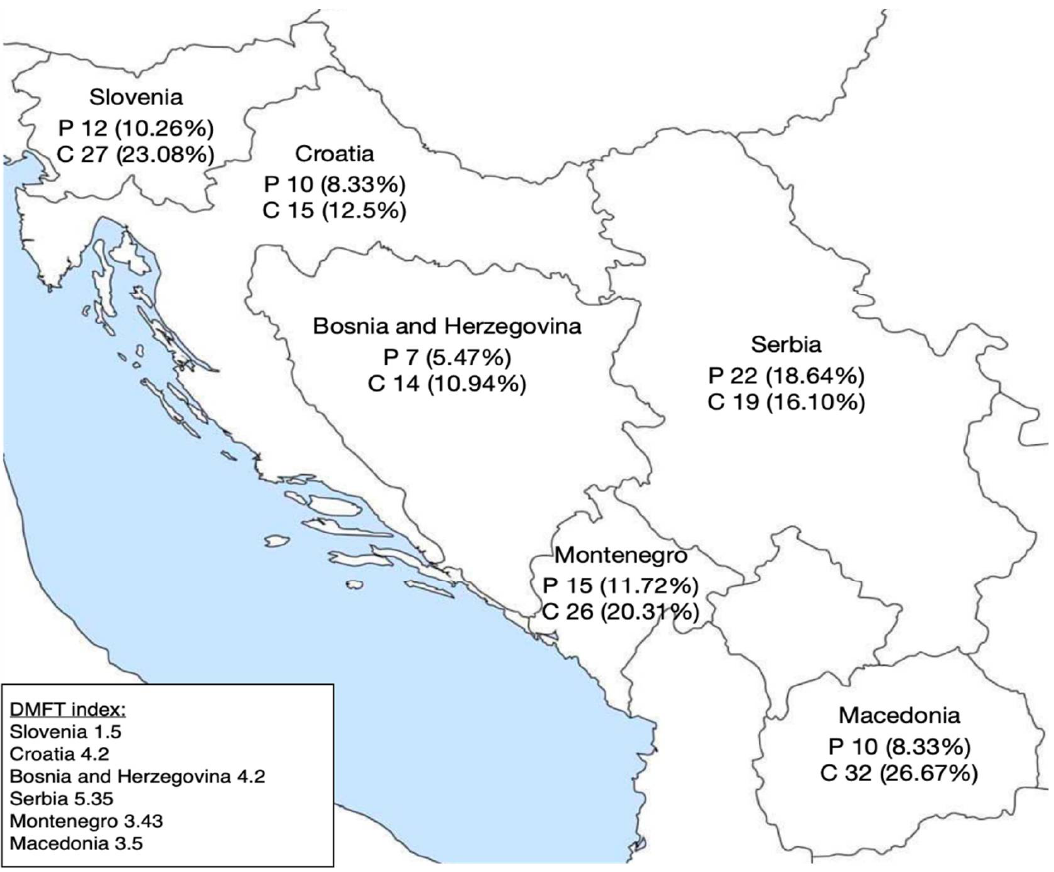
Figure 2. The geographical presentation of dental anxiety high levels and World Health Organiza- tion’s Decayed, Missing and Filled Teeth (DMFT) index [29–34]. [P—parent; C—child]. Kruskal–Wallis test H (5, n = 731) = 16.10819 p = 0.0065 confirmed a statistically sig-